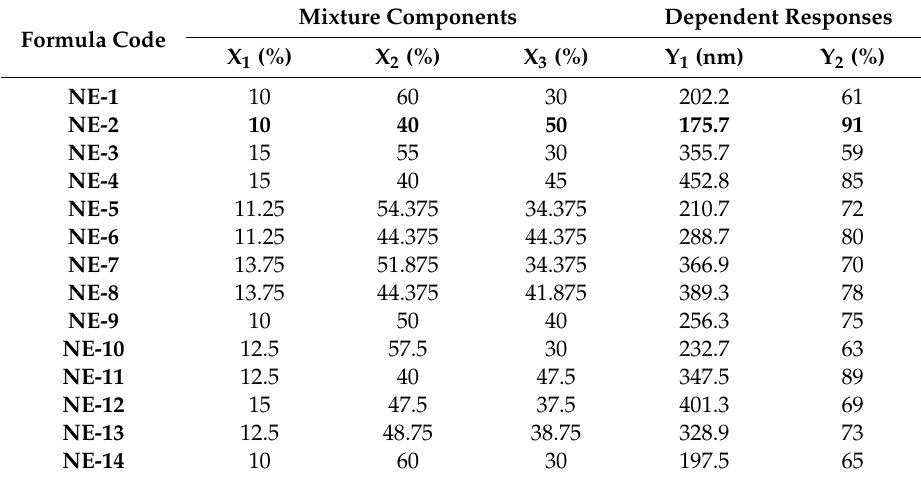
Table 2. Composition matrix and the observed mean globule size and stability index of FBX-NE formulations as suggested by the mixture